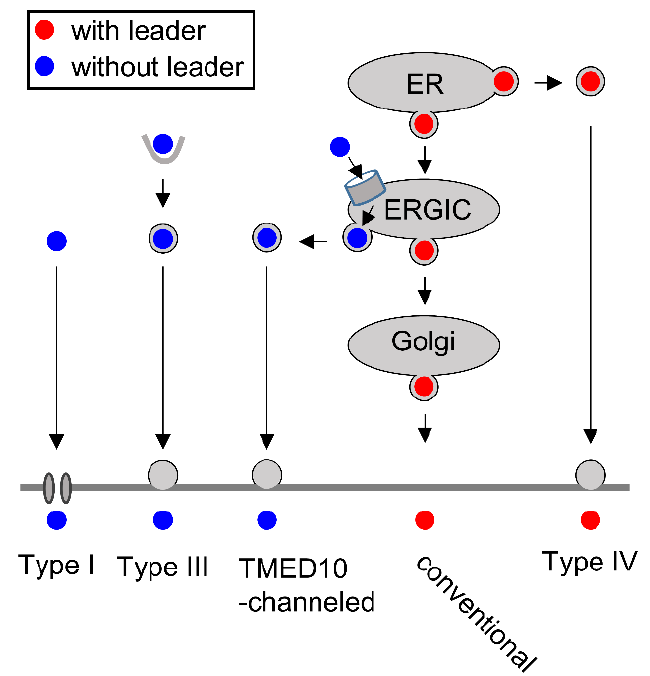
Figure 5. Pathways of protein secretion. Proteins with or without a leader are indicated. The type II secretion pathway is not displayed, as its occurrence and relevance in humans are not known, and also, the formation of lipid-bound extracellular vesicles is not visualized, as this process constitutes a separate research